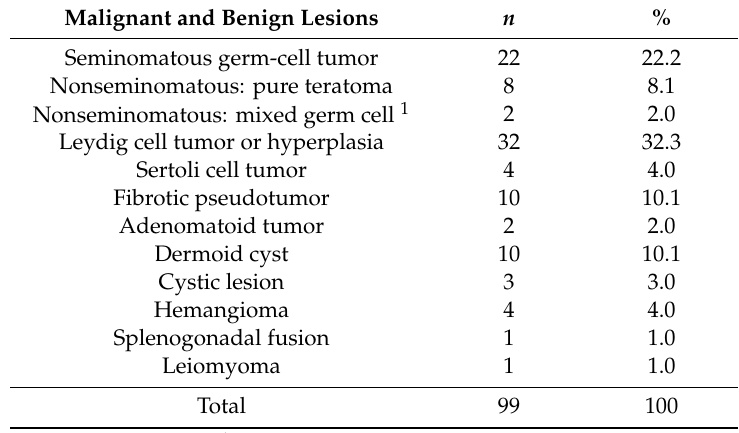
Table 4. Histopathological classification of the testicular tumors analyzed in this study.